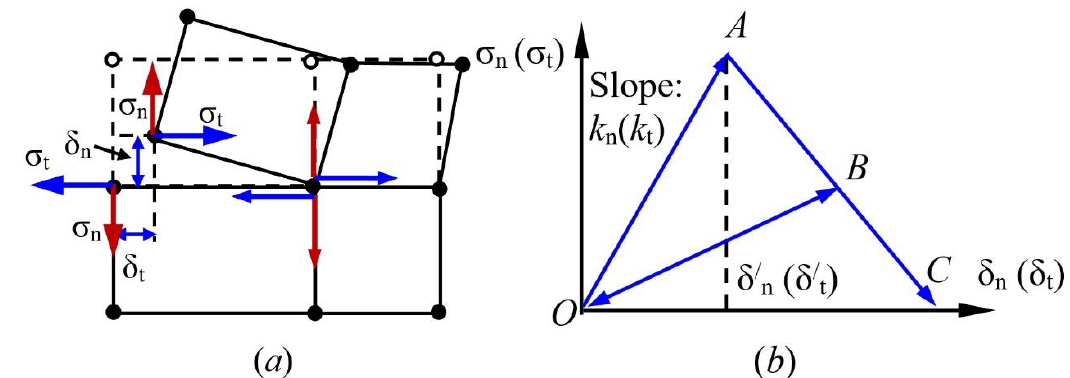
Figure 3. ( a ) Schematic node normal and tangential stresses and displacements in CZM- based FEM modeling of the debonding process of clay nanoparticles in PNCs. ( b ) Schematic σ n - δ n and σ t - δ t relations of a bilinear CZM.